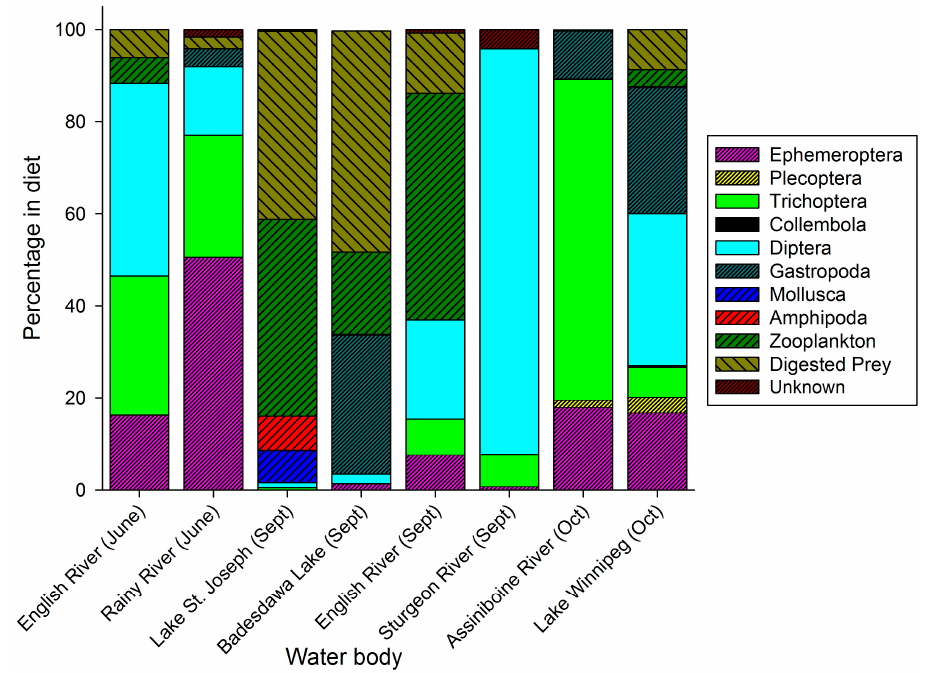
Figure 5. Common diet items in the stomach contents of seven River Darter populations collected in 2013–2014.